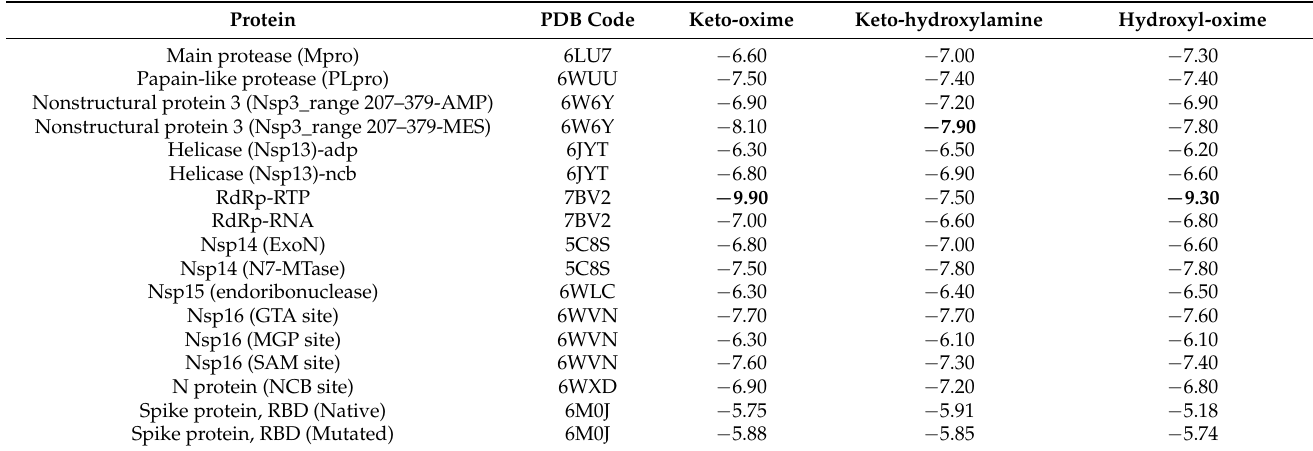
Table 9. The best poses of the keto-oxime, keto-hydroxylamine, and hydroxyl-oxime tautomers of molnupiravir inside the binding sites of the listed